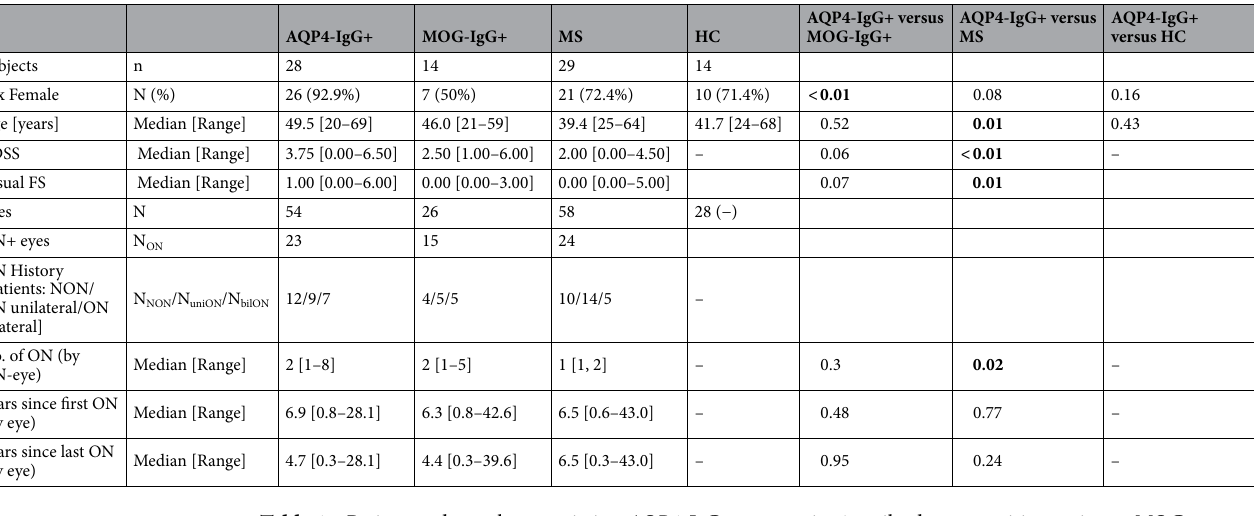
Table 1. Patient and eye characteristics. AQP4-IgG + aquaporin-4 antibody seropositive patients, MOG- IgG + myelin-oligodendrocyte-glycoprotein antibody seropositive patients, MS multiple sclerosis, HC healthy control, SD standard deviation, EDSS expanded disability status scale, FS functional system, ON optic neuritis. P -values from Fischer´s Exact Test (sex ratio) or Mann–Whitney-U test (all other items); statistically significant results are printed in